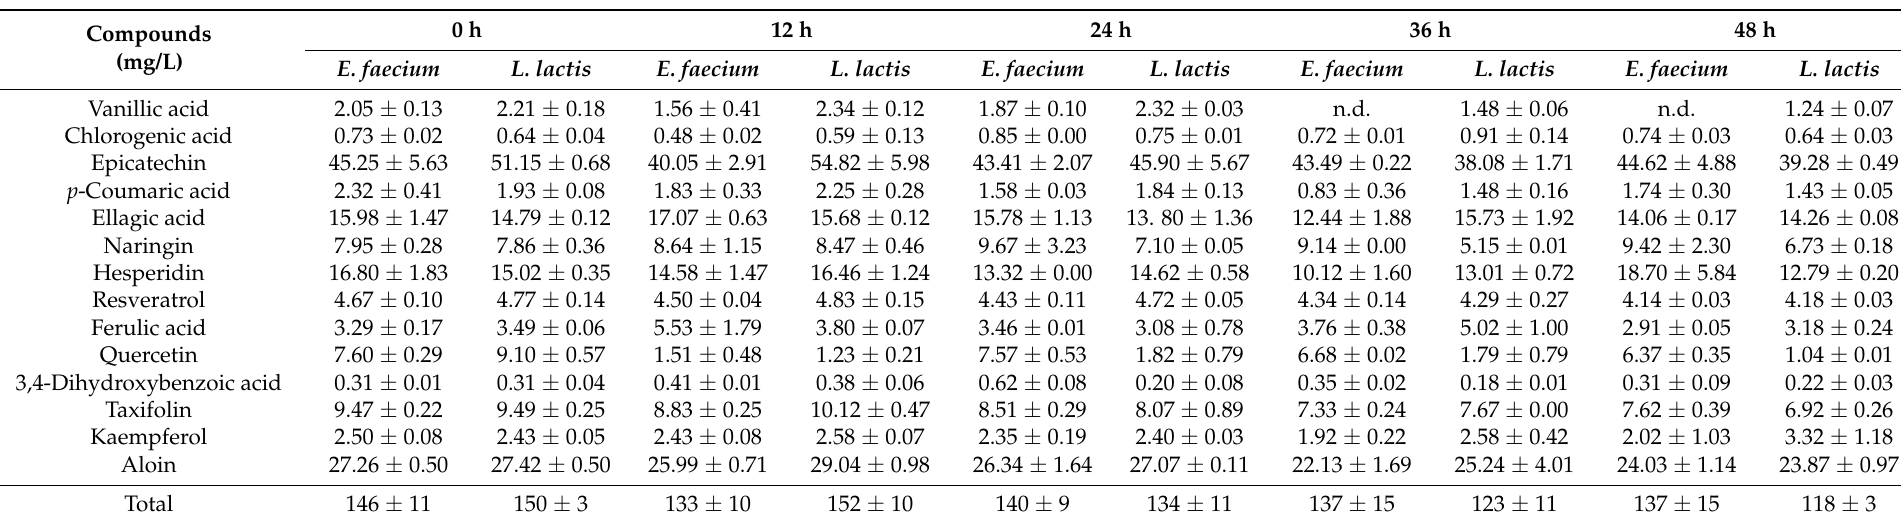
Table 1. Individual phenolic compounds and aloin determined in the Aloe vera juice during fermentation by Enterococcus faecium and Lactococcus lactis .